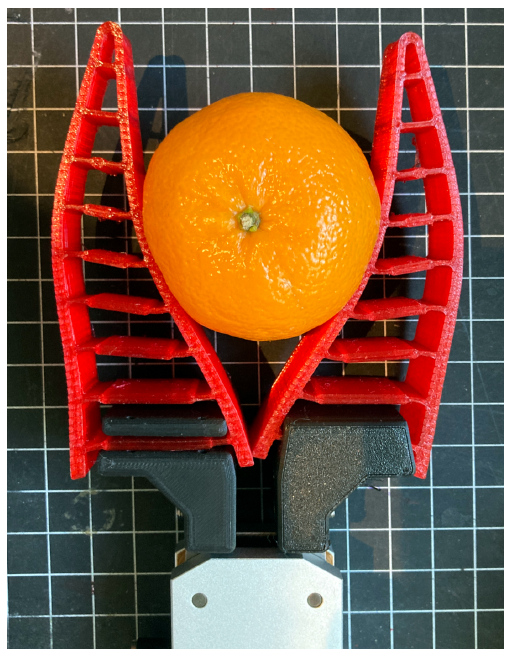
Figure 2. PaCoMe adaptive finger prototypes attached to Schunk